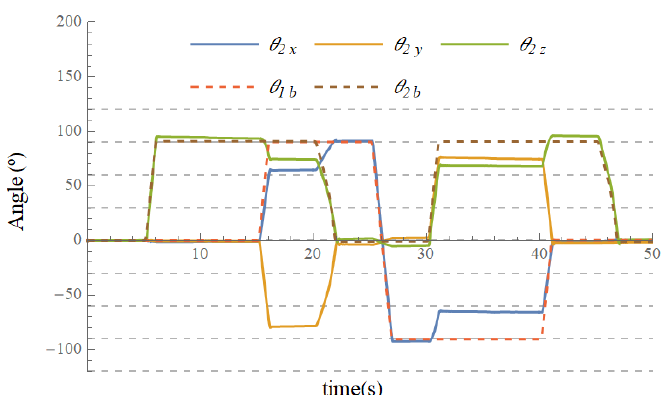
Figure 6. Evolution of Rotation Vector 2 when testing the link model using only gyroscope measure-